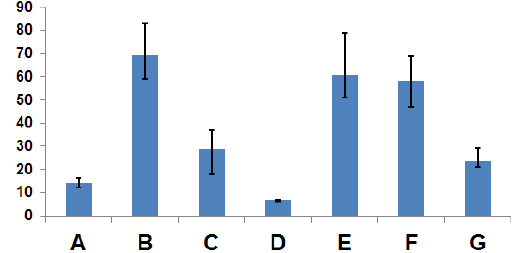
Fig. 1. Classification of compounds found in the quartz filter samples into main chemical groups. (A) Halogenated compounds, (B) hydrocarbons, (C) nitrogen compounds, (D) sulphur compounds, (E) carboxyl compounds, (F) hydroxyl compounds and (G) carbonyl compounds. The y-axis is the number of detected compounds.